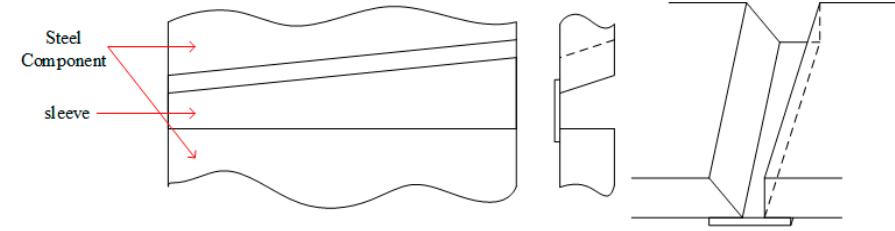
Figure 4. Non-standard grooves (unidirectional linear variation of bottom clearance).